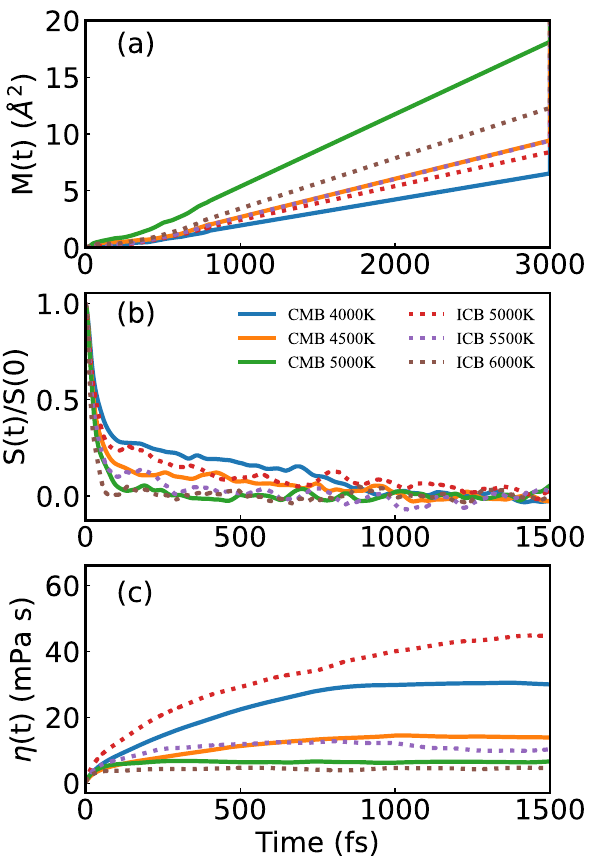
Figure 2. ( a ) Mean squared displacements of Fe–Fe M(t), ( b ) autocorrelation function of traceless stress tensor S(t) and ( c ) time evoluted viscosity η(t) in FeNi fluid under Earth’s core condition. The label ‘ICB’ and ‘CMB’ represent 330 GPa and 136 GPa, respectively. The S(0) is velocity-velocity autocorrelation function at t =